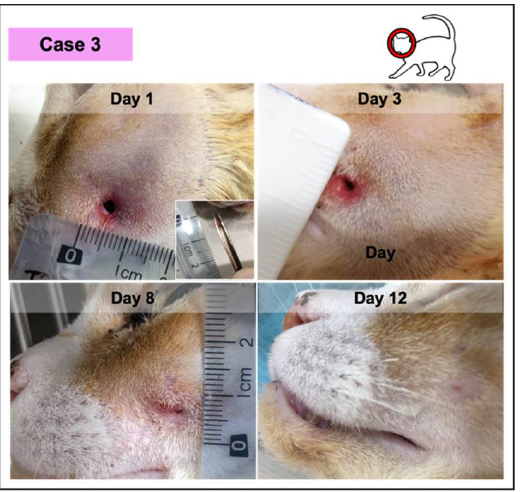
Figure 5. Photographic record of wound healing progression of case 3, diagnosed with an abscess with green purulent discharge. This feline was anemic and positive for the immunodeficiency virus.